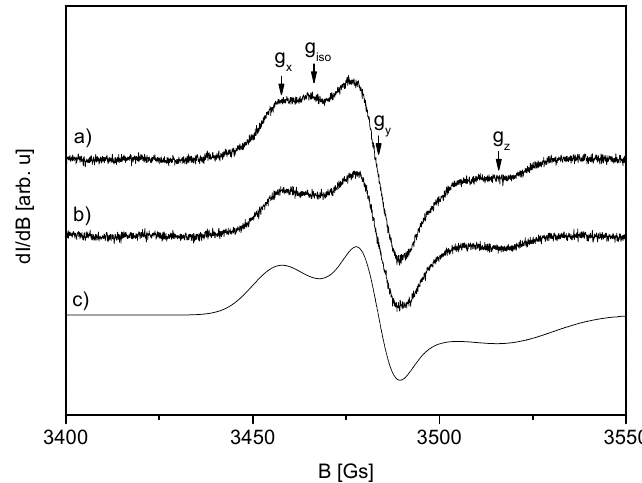
Figure 3. Electron Paramagnetic Resonance (EPR) spectra of the ERP sample recorded at 48.5 ( a ) and 355.5 ( b ) hours after irradiation (25 kGy) ( c ) presents the simulated anisotropic spectrum according to the parameters described in the text.